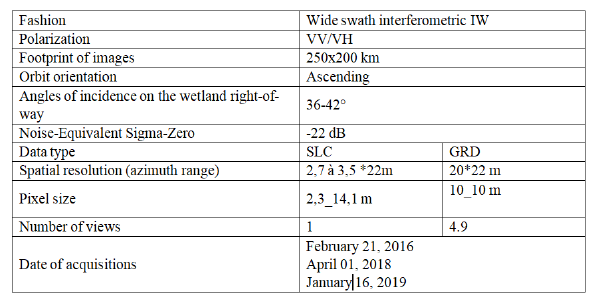
Table 2 . Characteristics of Sentinel-1 images (Aulard-Macler et al. 2011) Sentinel-1 data are mainly acquired in C band (λ = 5.6cm) and with the VV / VH configuration of the Interferometric Wide swath (IW) mode on Moroccan territory.